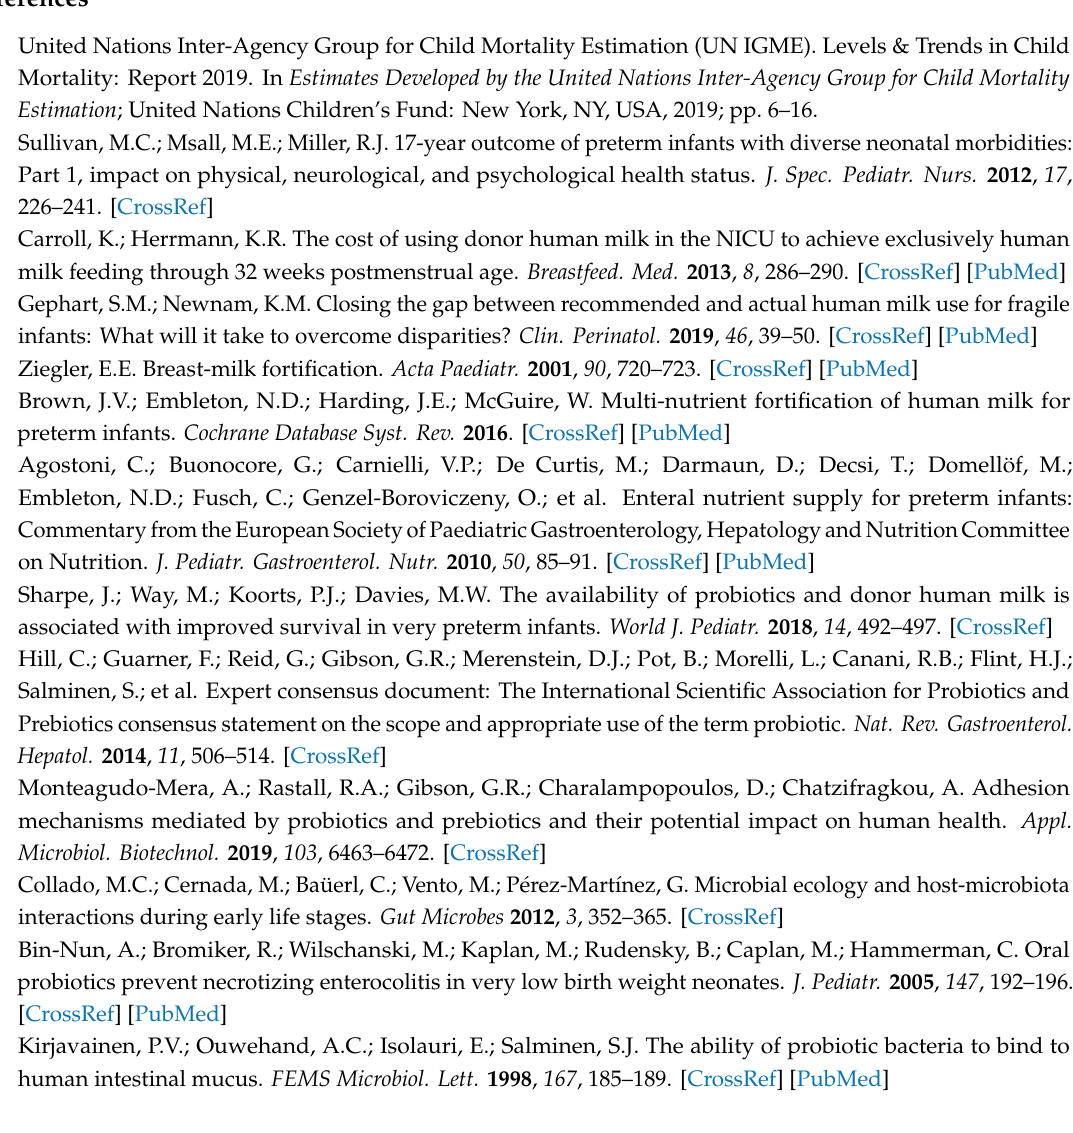
Figure S1: Mucus adhesion of L. rhamnosus GG (1) and B. lactis Bb12 (2) in fortified donor human milk (FDHM) or after initial mucus treatment with FDHM as presented with box plot with outliers marked with a circle